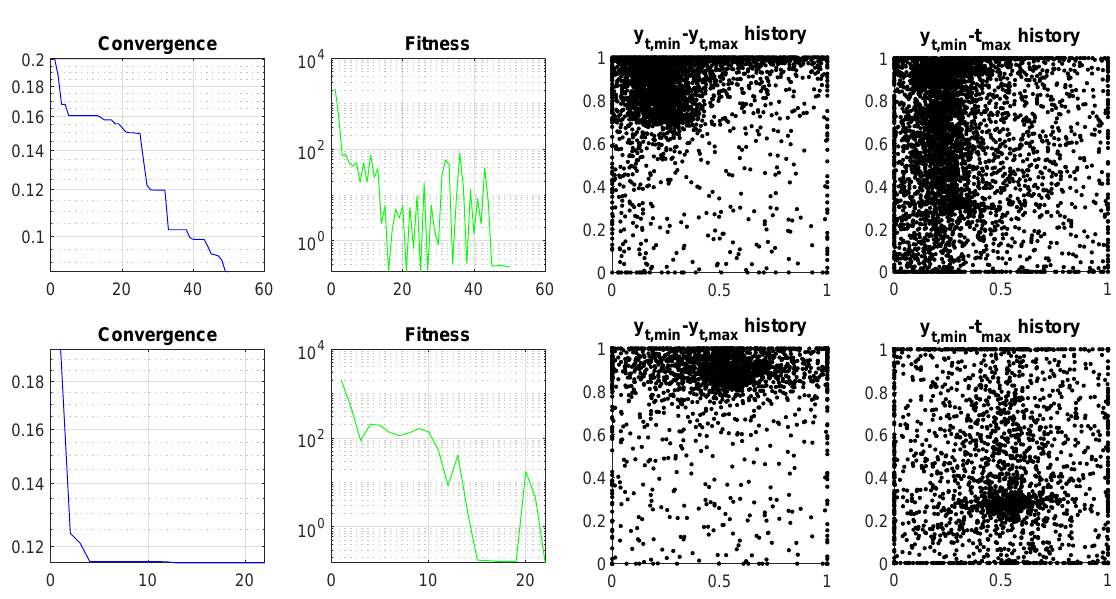
Figure 7. From left to right: blue plot is the convergence of the PSO algorithm (minimum value of f ( x ) ), green plot is the fitness of the population (mean value of f ( x ) ) both plots horizontal axes are the PSO iterations. The two scatter plots represent different planes in the optimization space x , y t , min - y t , max and y t , min - t max respectively. Axes are dimensionless. Swarm Population: 120. Top line : one mandate (4 years), bottom line : two mandates (8 years). Full results in the